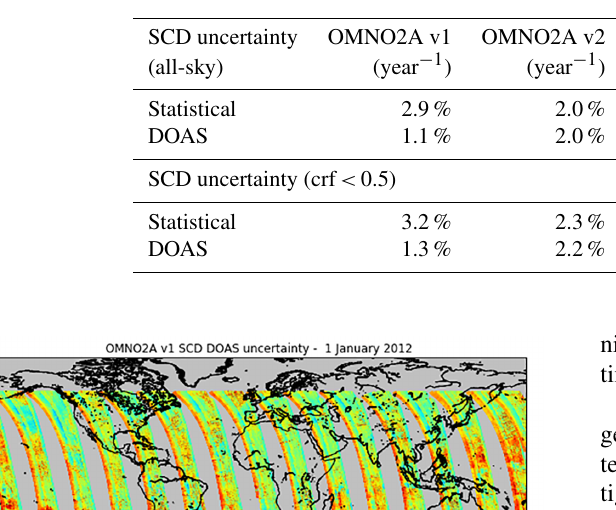
Table 6. Yearly increase of the statistical and DOAS uncertainty estimates of OMI NO 2 SCDs for OMNO2A v1, v2, OMINO2–QA4ECV, and OMNO2–NASA algorithms for the Pacific orbit from day 1 of January, April, July, and October (or closest available data) 2005–2015 for all-sky conditions (top panel) and clear-sky conditions (bottom panel).